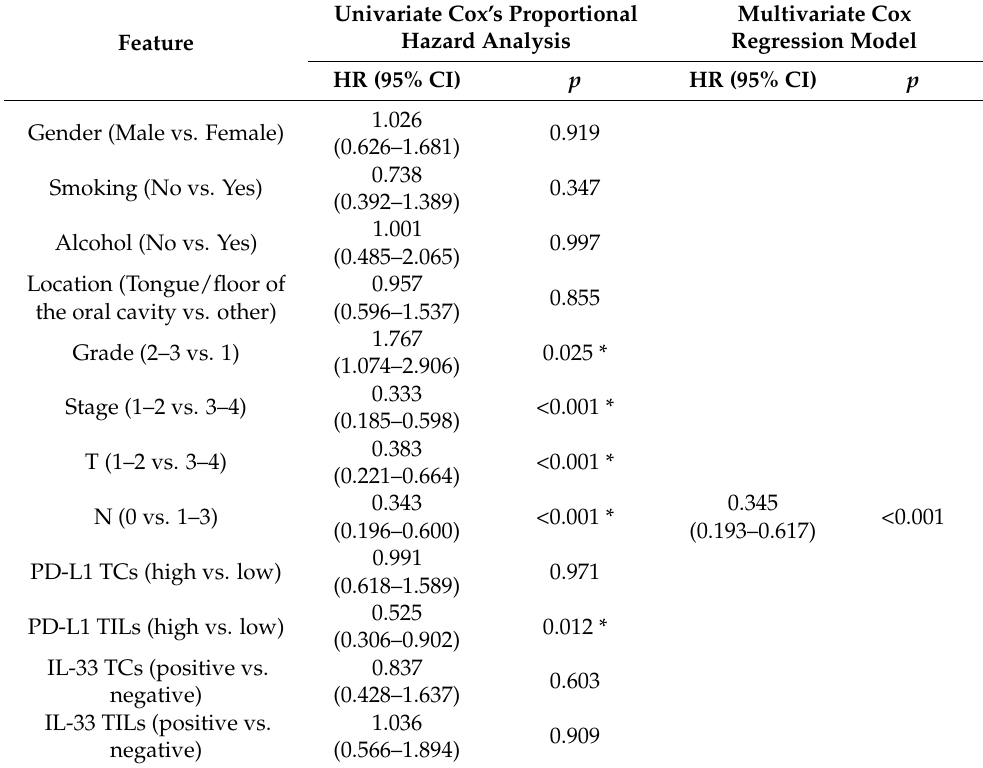
Table 2. The univariate and multivariate Cox’s proportional hazard analysis (HR—hazard ratio; 95% CI—confidence interval; p — p value; *—statistically significant p